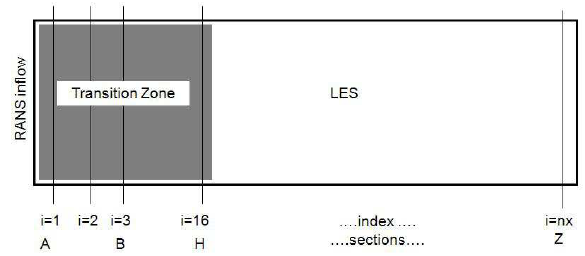
Fig. 3. Sketch of the channel flow case with the buffer sub-domain. With indexes are denoted the sections used in the comparison.